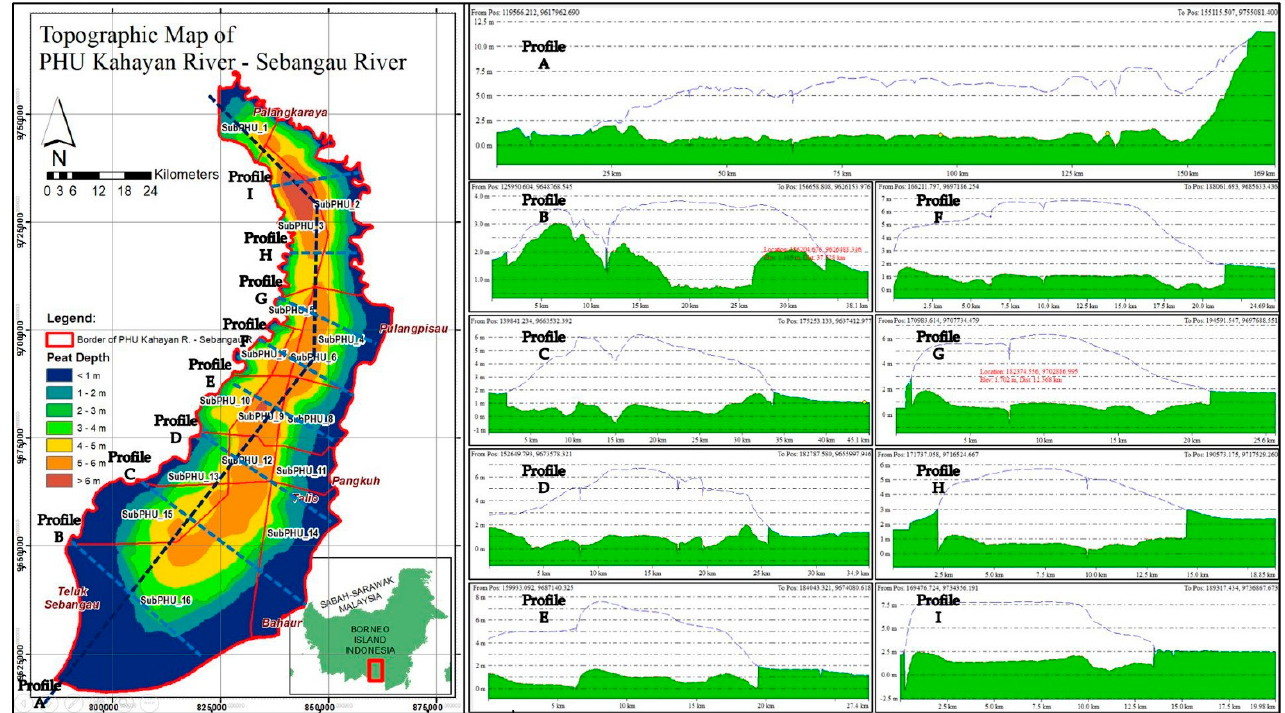
Figure 10. The map of peat depth ( left ) and the representation of peat soil thickness in cross-profiles ( right ) in the Kahayan–Sebangau PHU consider the topographic position of the soil surface (blue line) and mineral soil elevation (green). (data source: BRGM-RI; processed by the authors).